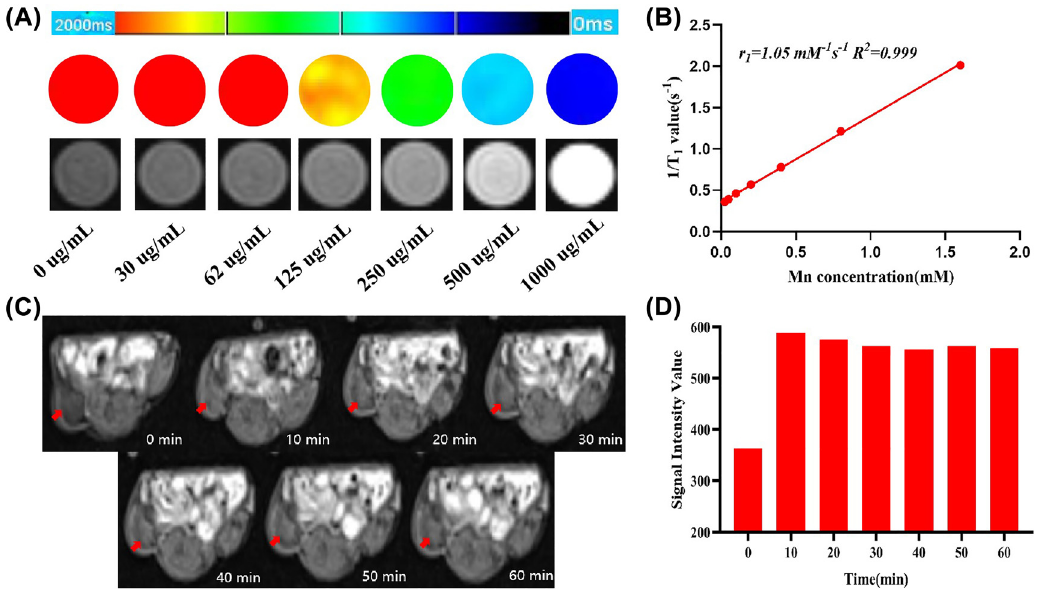
-weighted MRI of Mn-Ti Figure 3: T 1 C @PEG at various concentrations buffer solution after incubation. (B) longitudinal relaxation rate ( r Mn-Ti 3 2 over the corresponding Mn-Ti of 1/T 1 40, 50, and 60 min after intravenous injection of Mn-Ti tumor contrast collected at different time after administration of Mn-Ti the location of the